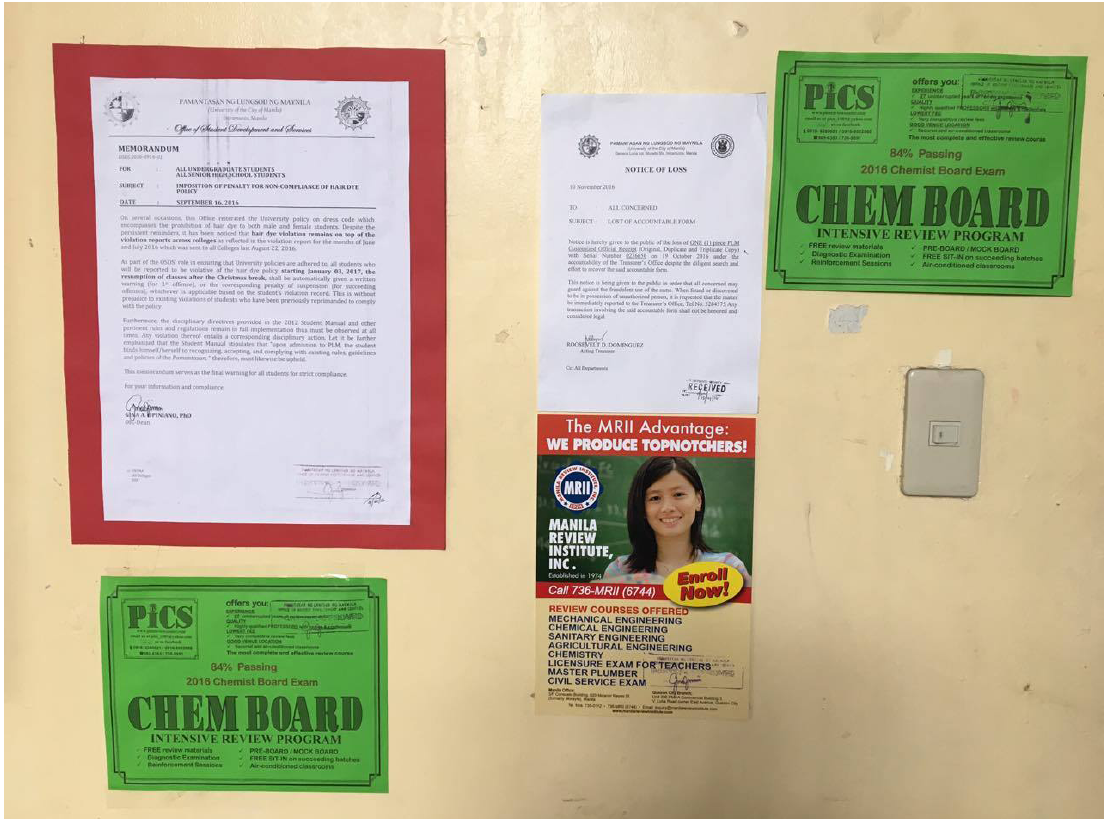
Figure 1. Monolingual signs. Announcements in English, whether for official or promotional purposes, are found on walls and billboard displays in many public and private universities in the